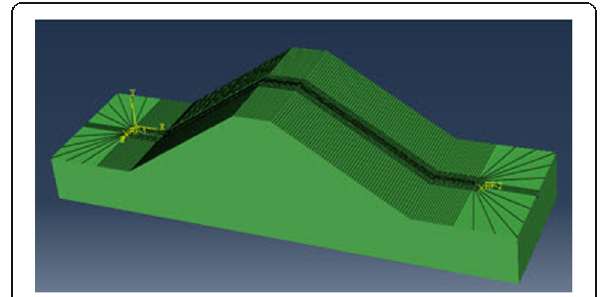
Fig. 7 3D model used for analysis ( SF = 0.5)